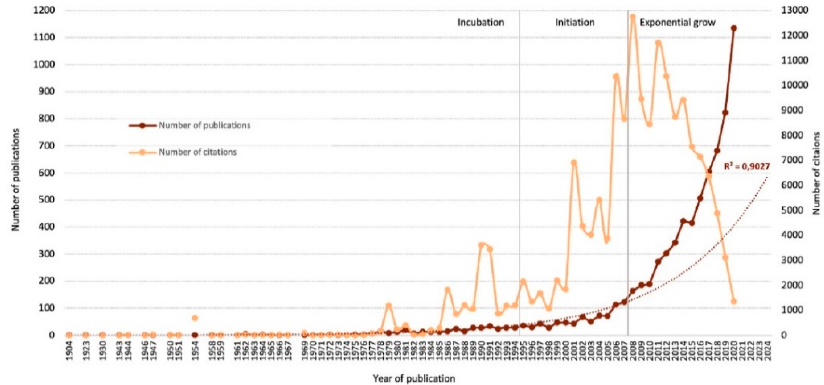
Figure 2. Temporal distribution of the published articles and citations received in POP and growth prediction for the next four years.